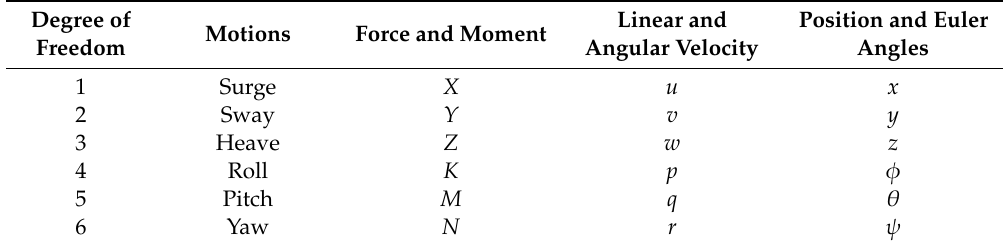
Table 1. Society of Naval Architects and Marine Engineers (SNAME) notations for underwater vehicles (data from